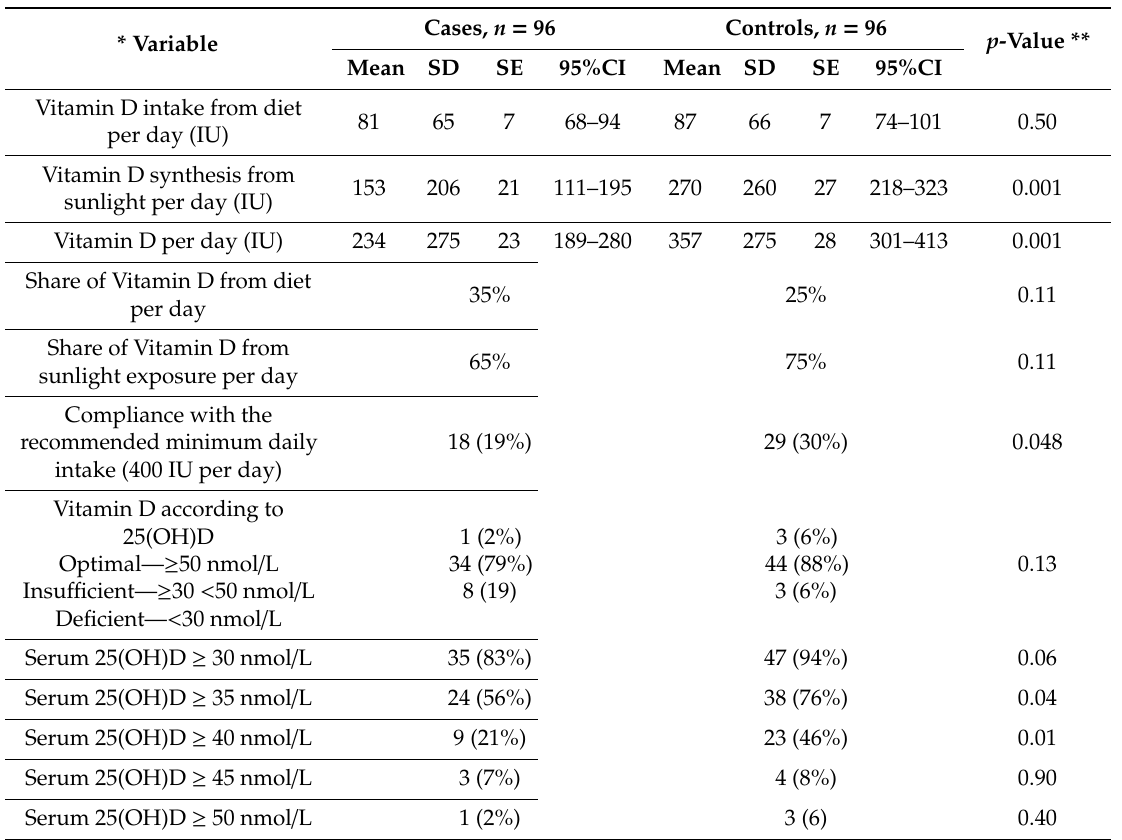
Table 2. Vitamin D status of the study